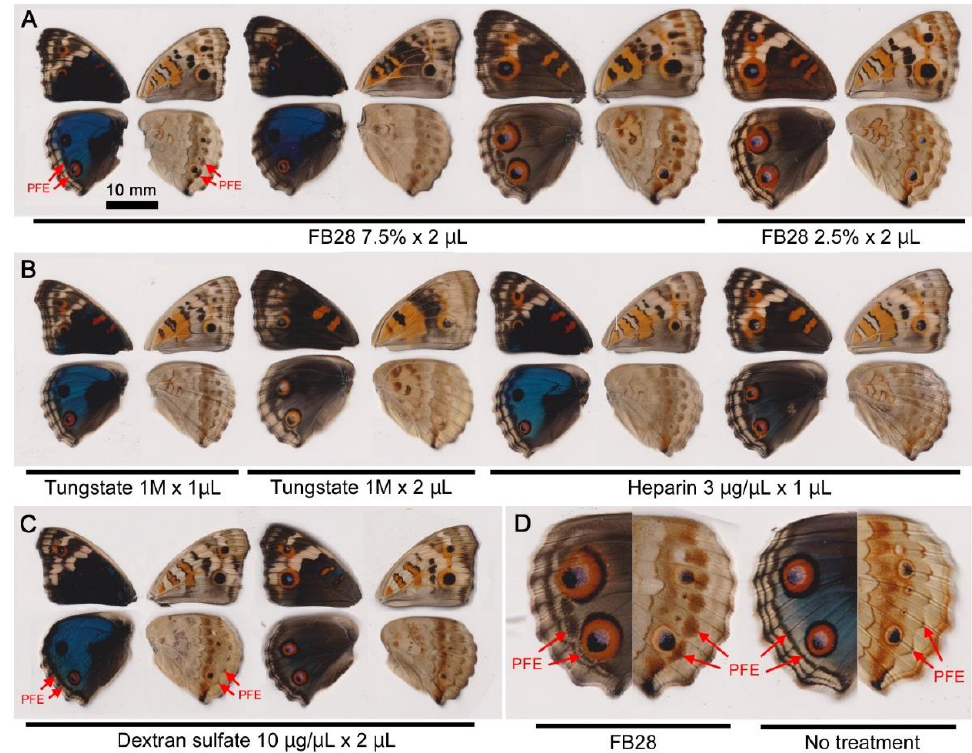
Figure 3. Color pattern modifications induced by FB28 and other modification inducers. ( A ) FB28. ( B ) Previously known modification inducers, tungstate and heparin. These treatments cause similar